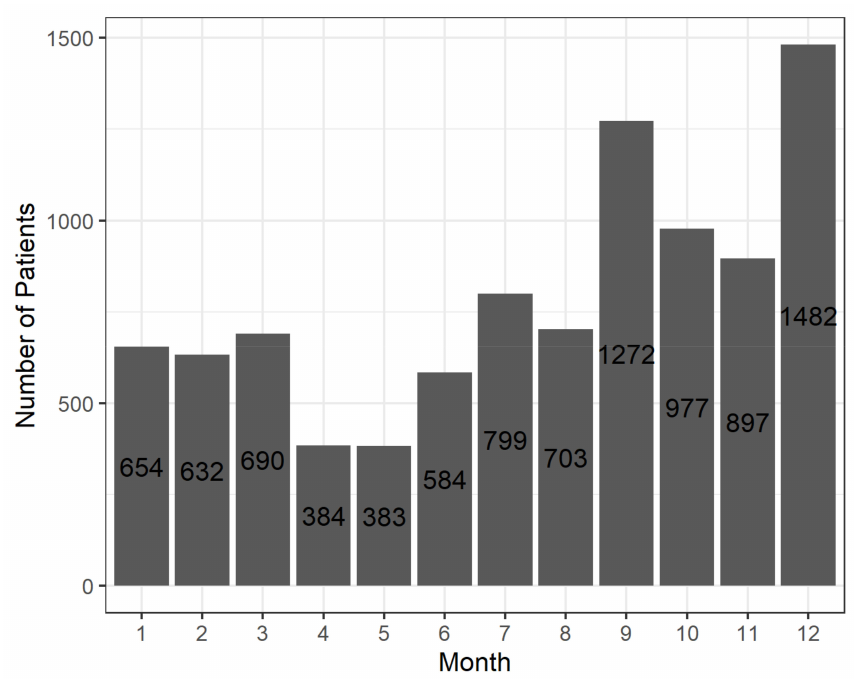
Figure 7. Number of patients stratified by month of the year when T 0 was